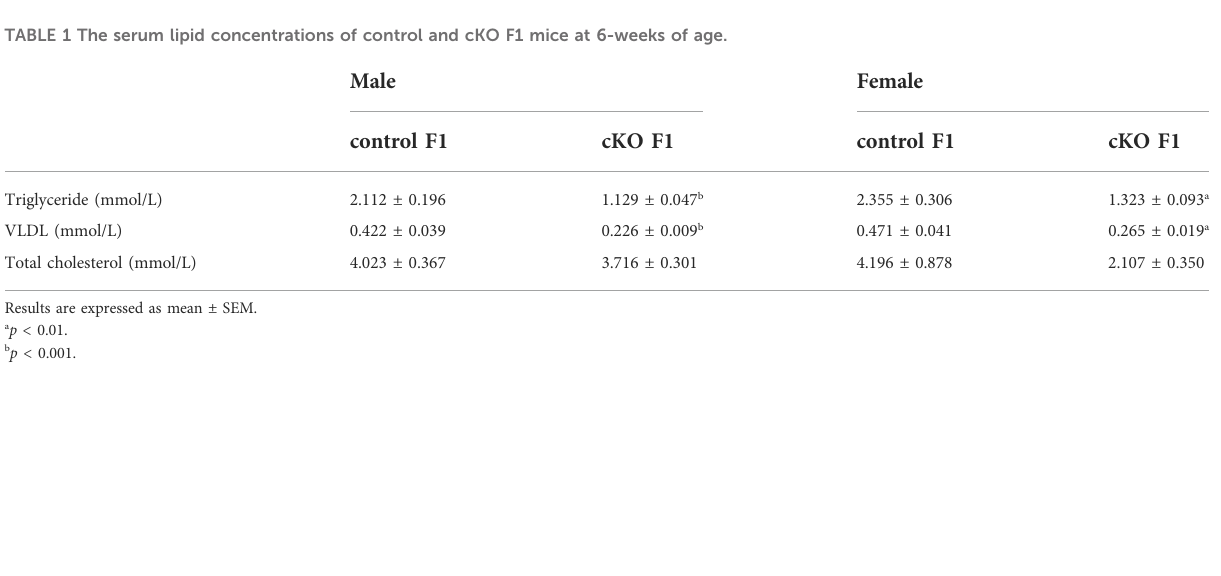
TABLE 1 The serum lipid concentrations of control and cKO F1 mice at 6-weeks of age.